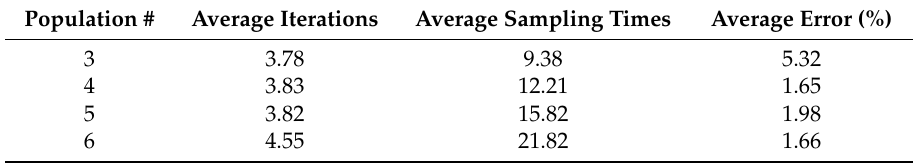
Table 8. Simulation results of the MFA with different population numbers under the 10